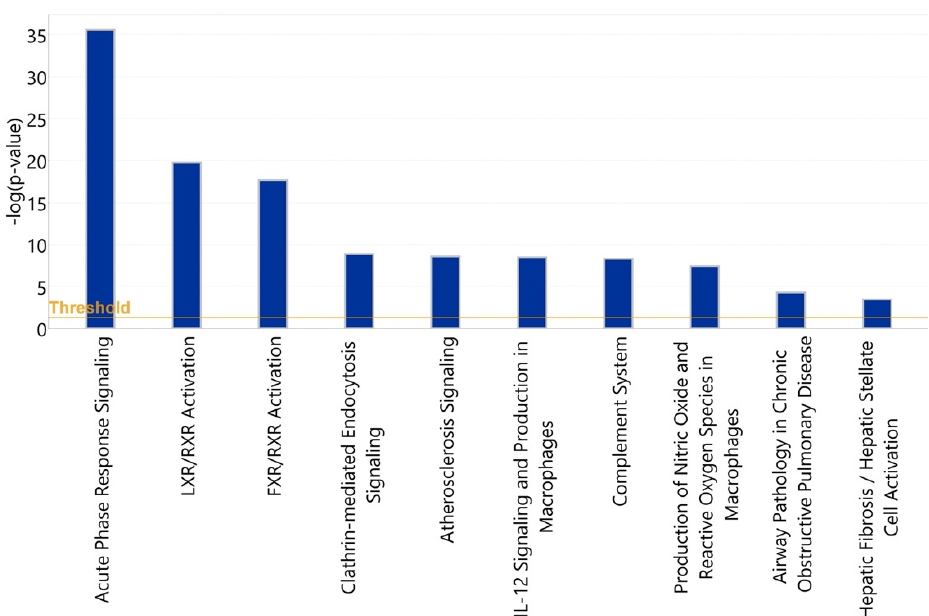
Figure 16. Acute-phase proteins identified by this study and the study by Shen et al. Adapted from [21].